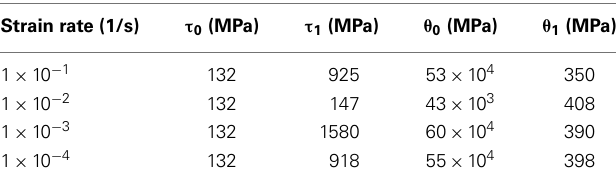
Table 1 |Voce hardening parameters utilized in the currentVPSC simulations